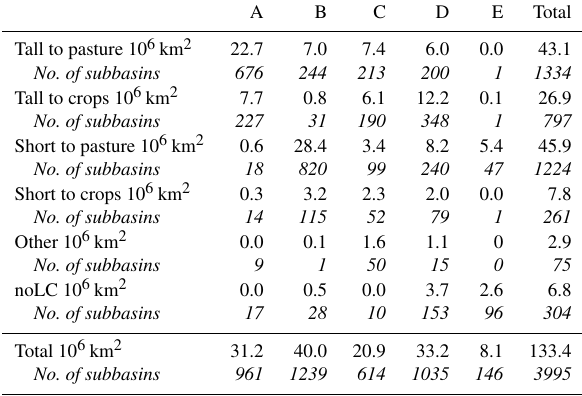
Table 2. Area (in 10 6 km 2 , and number of subbasins in italics) per land cover change and per Köppen–Geiger classification, based on 2000 minus 1850 land cover. A represents equatorial climates, B is arid, C is warm temperate, D is snow and E is polar (Kottek et al., 2006). Subbasins are divided into land cover change groups based on which natural land cover reduces most and which anthropogenic land cover increases most in a subbasin. Rainfed and irrigated crops are grouped together, as this subdivision will be used to analyze the impact of land cover change, where all crop land cover types are rainfed (LC2000 vs. LC1850). “Other” refers to those areas where tall or short natural vegetation is replacing crops or pasture; “noLC” refers to subbasins where no land cover change occurs. See also Fig.